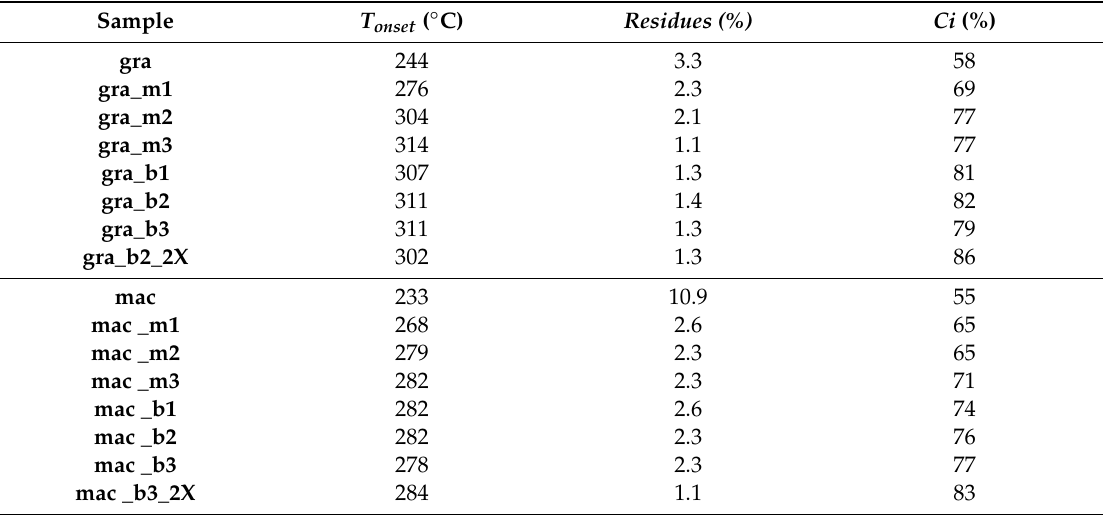
Table 3. T onset , residues content and Ci of gravata and macauba raw, mercerized and bleached